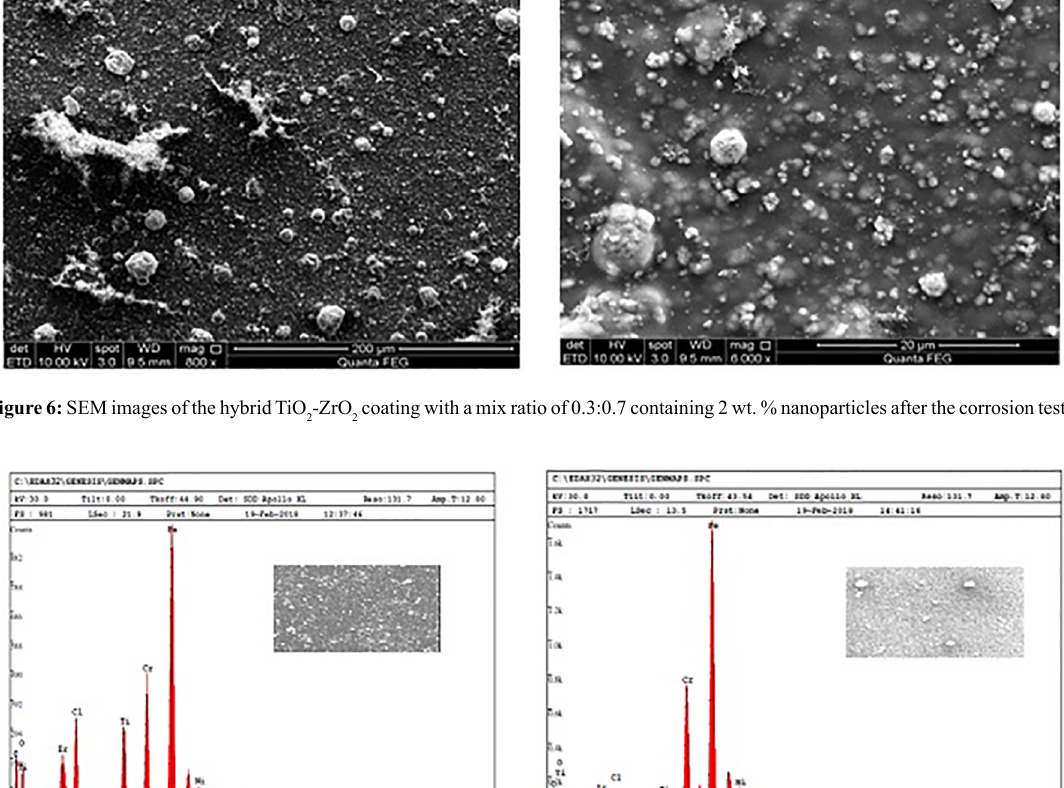
Figure 7: ( a) EDX spectrum and quantitative analysis of the coated AISI 304 steel with hybrid TiO 0.5:0.5 containing 2 wt. % nanoparticles after the corrosion test, (b) EDX spectrum and quantitative analysis of the coated AISI 304 steel with the hybrid TiO -ZrO coating with a mix ratio of 0.3:0.7 containing 2 wt. % nanoparticles after corrosion 2 2